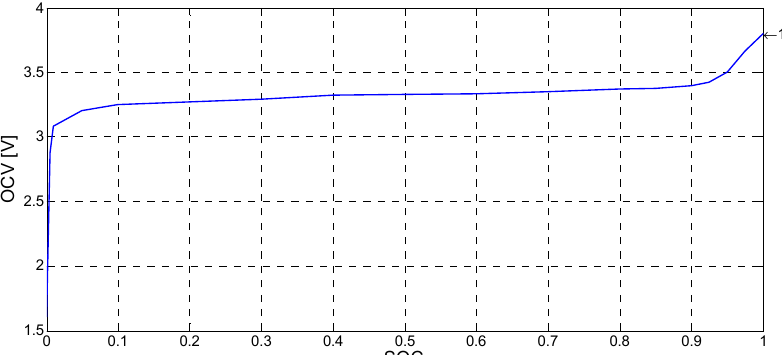
Figure 6. Power battery cell open circuit voltage-SOC curve. Table 5. Battery values.